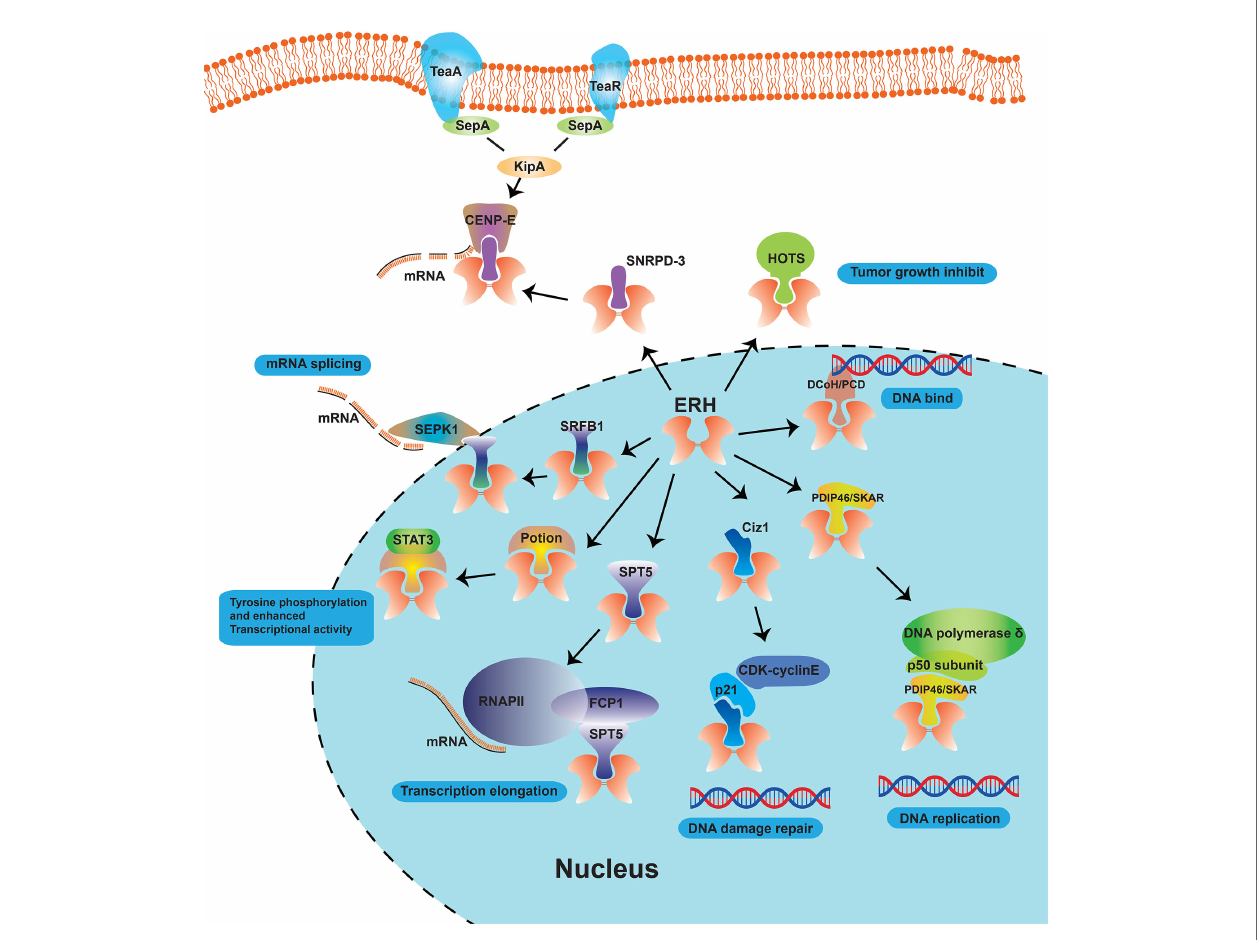
FIGURE 2 | Schematic diagram of the role of ERH proteins as molecular partners in cells. The ERH protein, as a nuclear protein, can interact with many proteins such as DCoH/PCD, SPT5, PDIP46/SKAR, Ciz1, HOTS, SNRPD-3 and DEPDC1B, and involved in many cellular functions like “ mRNA solicing ” , “ Tyrosine phosphorylation and enhanced Transcriptional activity ” , “ Transcription elongation ” , “ DNA damage repair ” ,